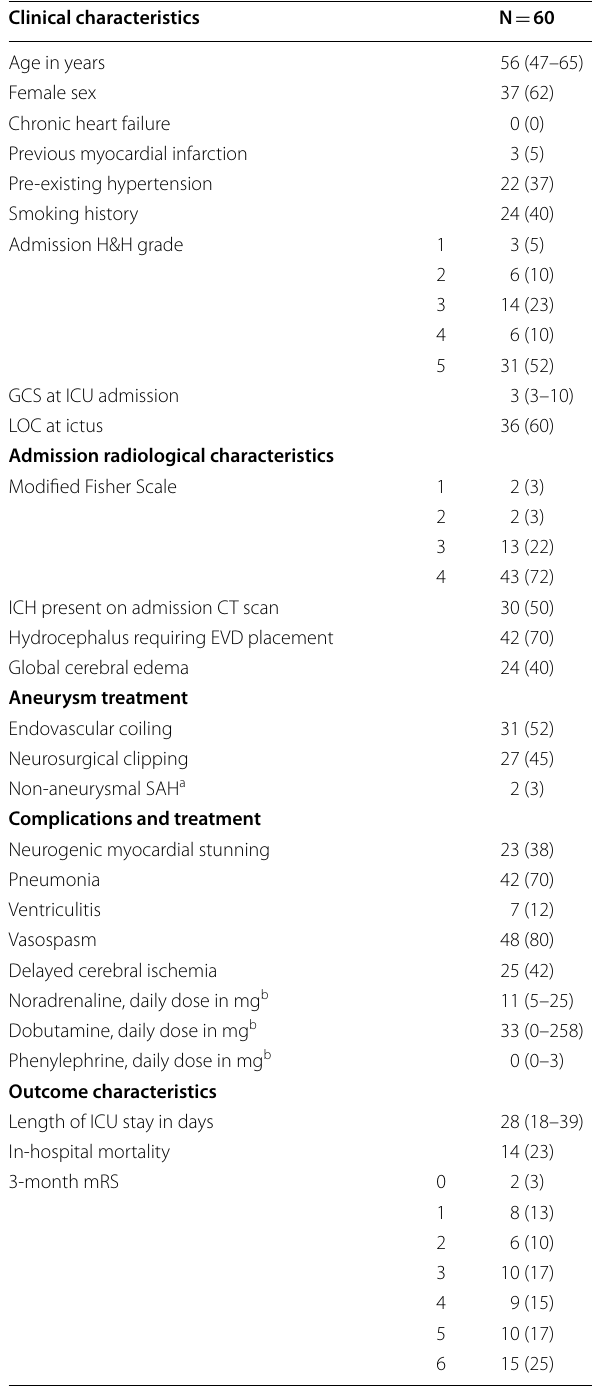
Table 1 Baseline characteristics, complications, and